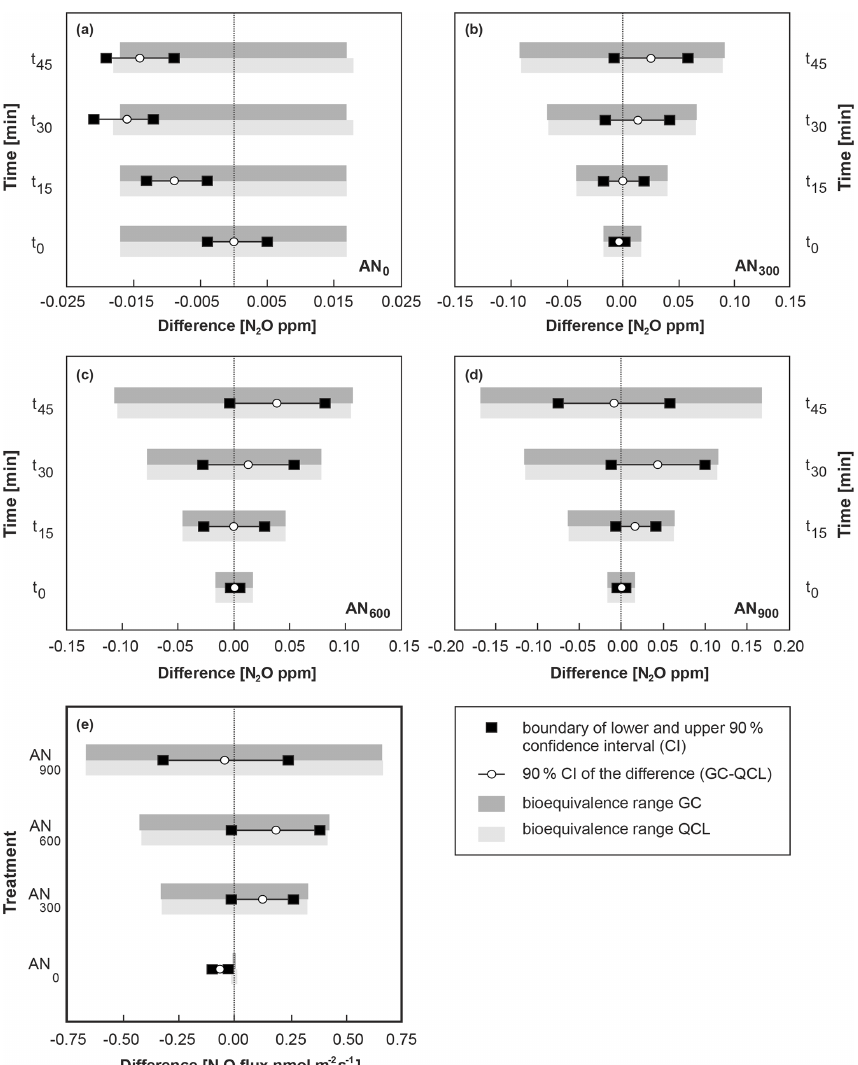
Figure 6. Bioequivalence analysis for N 2 O concentrations ( C N2O ) in (a–d) and N 2 O fluxes ( F N2O ) in (e) , with GC defined as the standard method. C N2O and F N2O based on QCL analysis were considered bioequivalent when the 90% confidence interval (CI) of the difference between QCL and GC ( x axis) was completely within the predefined ± 5% bioequivalence range of the difference of the standard method. The bioequivalence analysis was distinguished for C N2O by sampling interval ( t 0 , t 15 , t 30 , t 45 ) and treatment, with panel (a) showing results for control sites (AN 0 ) and panels (b) , (c) and (d) for AN 300 , AN 600 and AN 900 treatment sites. Similarly, a bioequivalence analysis was conducted for F N2O in panel (e) and distinguished by AN application rate on the y